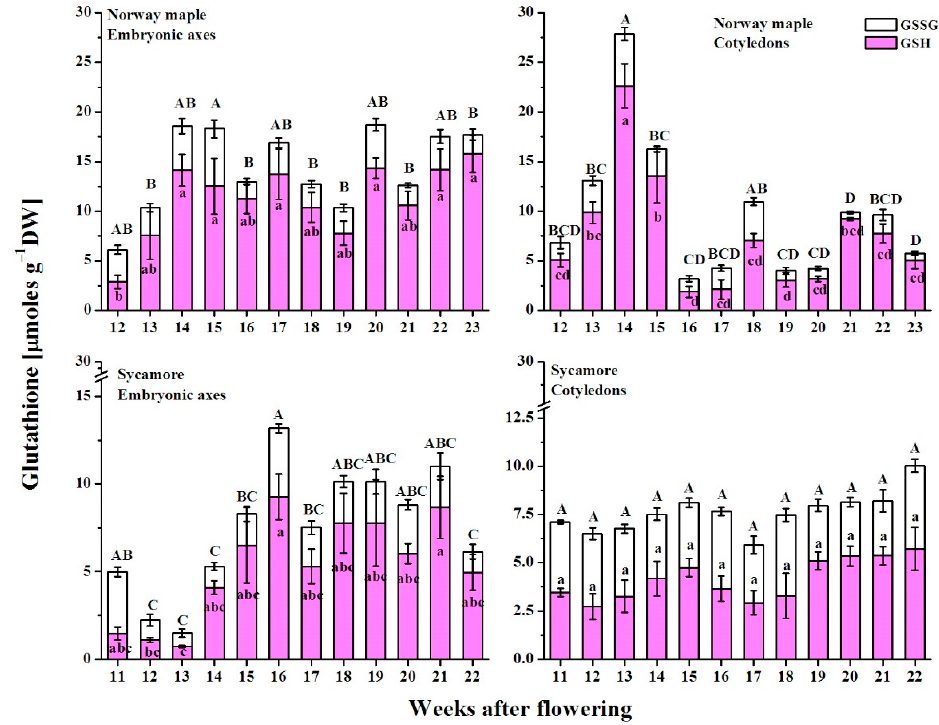
Figure 12. Changes in the levels of the reduced (GSH) and oxidized (GSSG) forms of glutathione reported in the embryonic axes and cotyledons of developing seeds of Norway maple and sycamore collected during the 11th–23rd weeks after flowering. Data are the means of three independent replicates ± the standard error. Statistically significant differences are indicated with different letters (one-way ANOVA, followed by Tukey’s test at p < 0.05). The capital letters refer to GSSG.